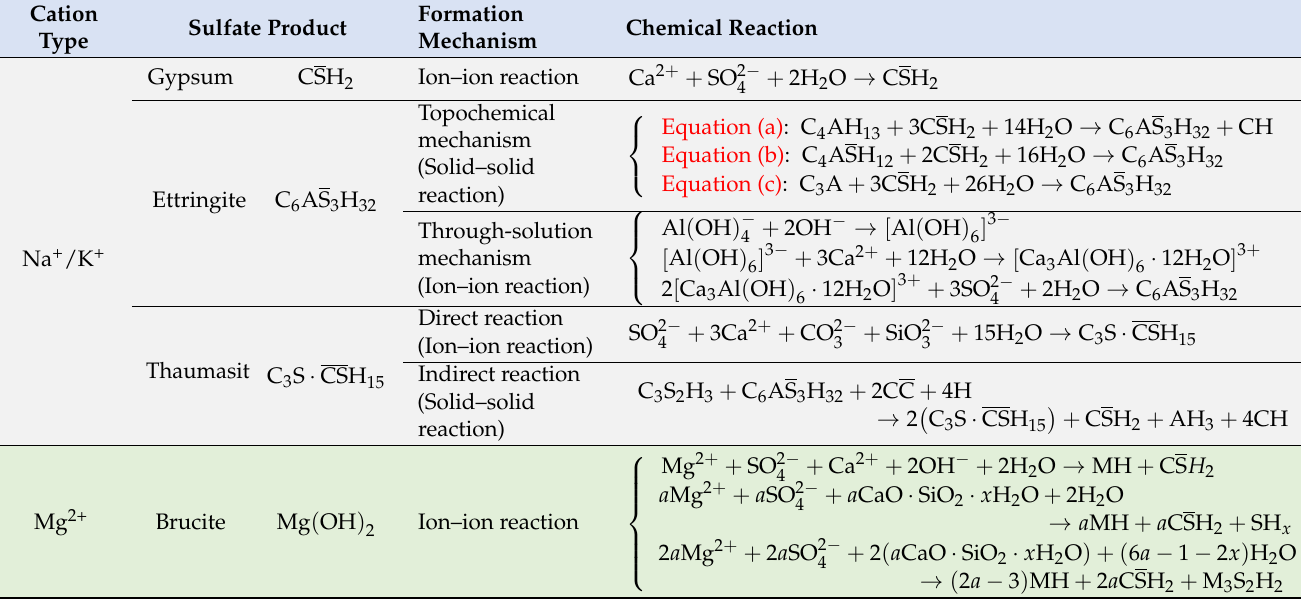
Table 1. Reaction equations and formation mechanisms of products in concrete.